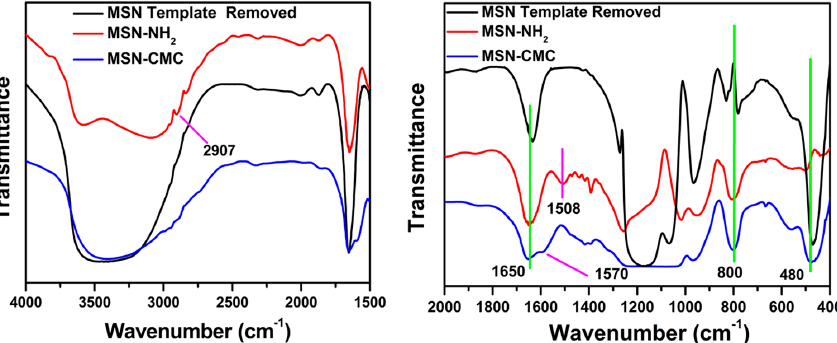
Figure 4. Fourirer Transform Infrared Spectroscopy (FT-IR) Spectra of MSN, MSN-NH 2 and MSN- CMC. Figure 3. ( a ) X-Ray Diffraction (XRD) patterns of MSN and MSN-NH 2 and ( b ) Thermogravimetric Analysis (TGA) curves of MSN, MSN-NH 2 and MSN-CMC.